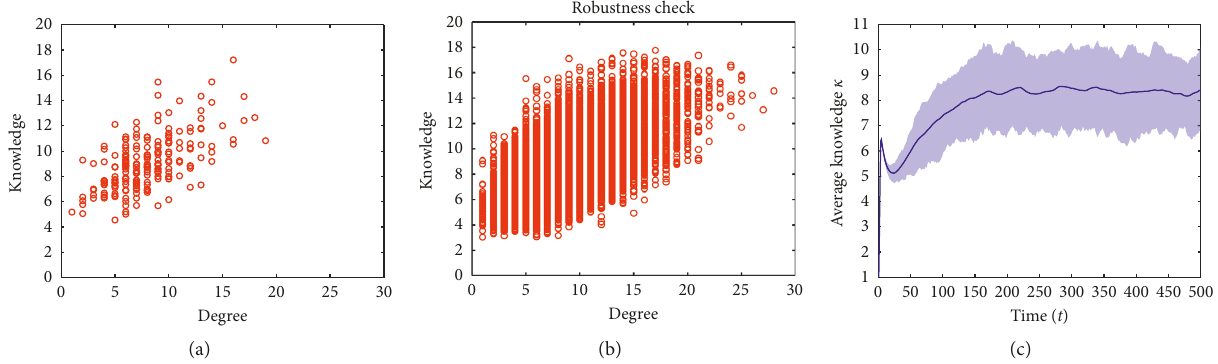
Figure 3: Evolution result when the initial R&D network structure is a BA scale-free network ( p � 0 .